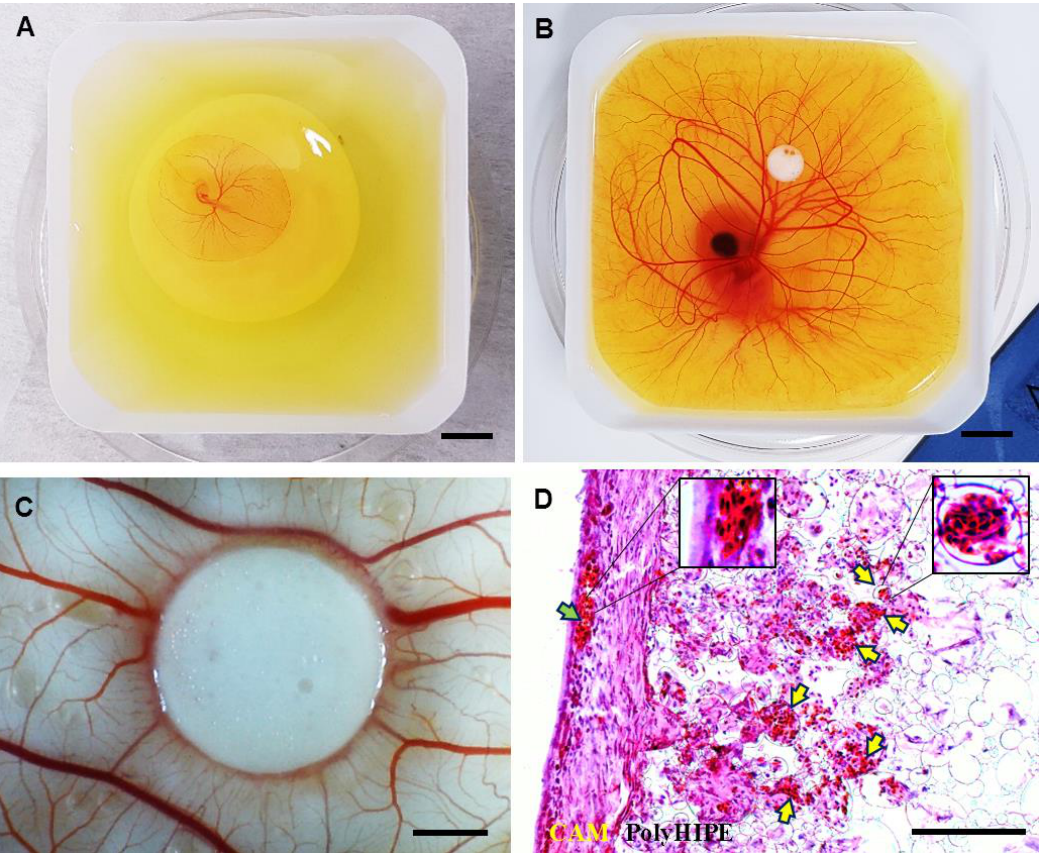
Figure 5. Chick embryos in a petri dish on ( A ) embryonic development day 3 and ( B ) embryonic development day 7 (Scale bar represents 10 mm). ( C ) PCL polyHIPE on chorioallantoic membrane (CAM) at day 14 (Scale bar represents 2 mm). ( D ) H&E image of PCL polyHIPE on CAM at day 14. (Green arrow indicates the blood vessel on the CAM itself; yellow arrows indicate the blood vessels in PCL polyHIPE (Scale bar represents 100 µ